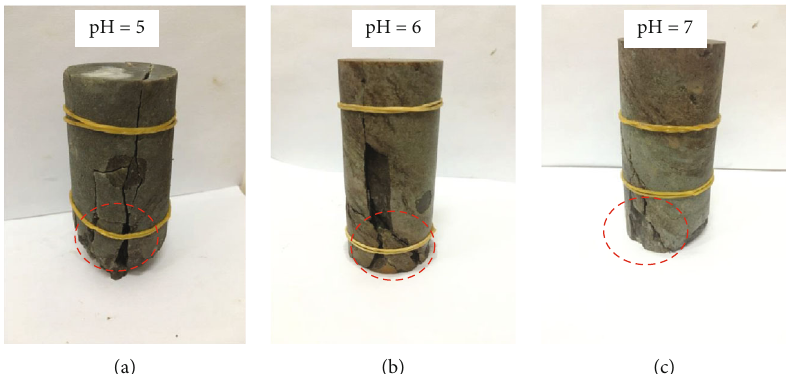
Figure 13: Uniaxial creep failure pattern of gypsum under acid corrosion. (a) Sample under the pH = 5 acidic solution. (b) Sample under the pH = 6 acidic solution. (c) Sample soaked with distilled water.